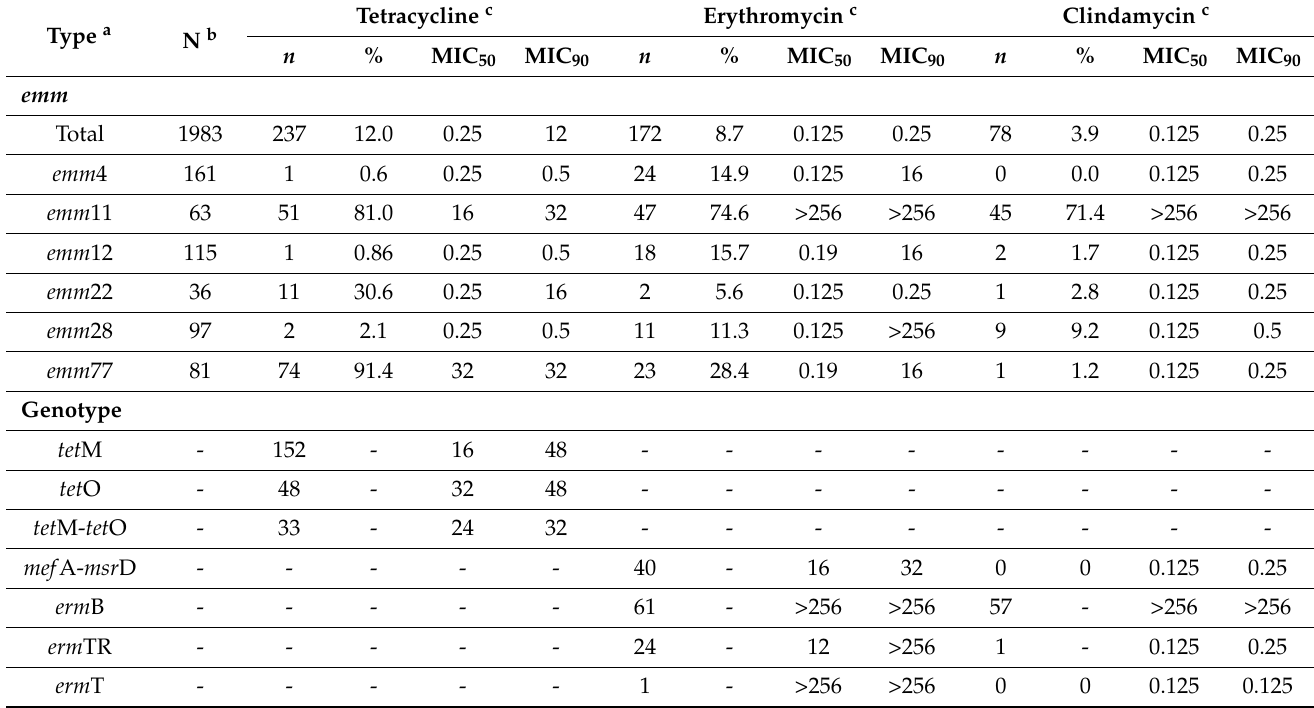
Table 1. emm types and genotypes of invasive Streptococcus pyogenes associated with tetracycline, erythromycin, and clindamycin resistance in Spain,